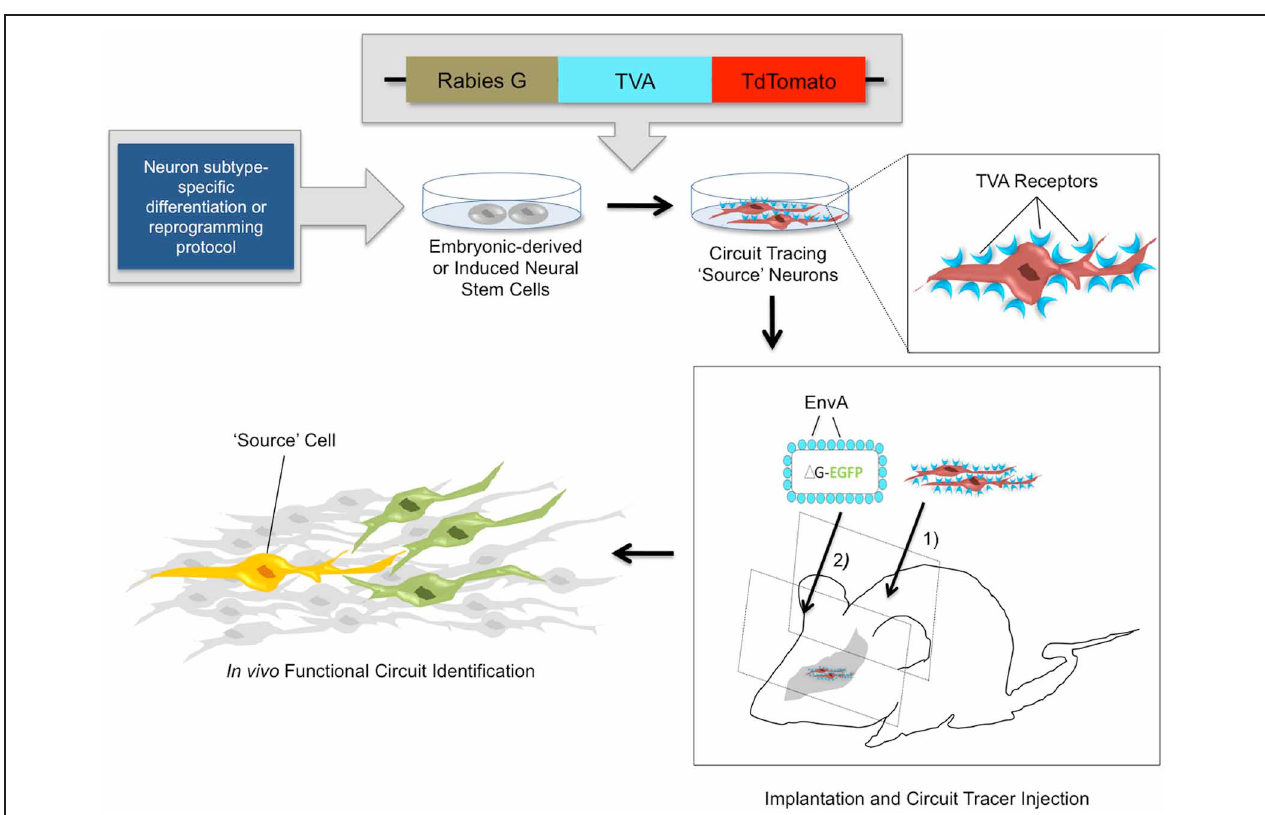
FIGURE 3 | In vivo circuit analysis with derived or reprogrammed neurons harboring viral circuit tracing elements. Using neuron subtype-specific differentiation or reprogramming protocols, a specialized population of neural stem cells can be obtained in vitro . Electroporation or stable transfection with a transsynaptic tracing vector provides the rabies G coat protein and the TVA receptor, which are components of the monosynaptic circuit tracing process. Incorporation of the viral tracing vector into the stem cell genome transforms these cells into “source” cells for circuit tracing. These cells can be implanted in vivo and identified by